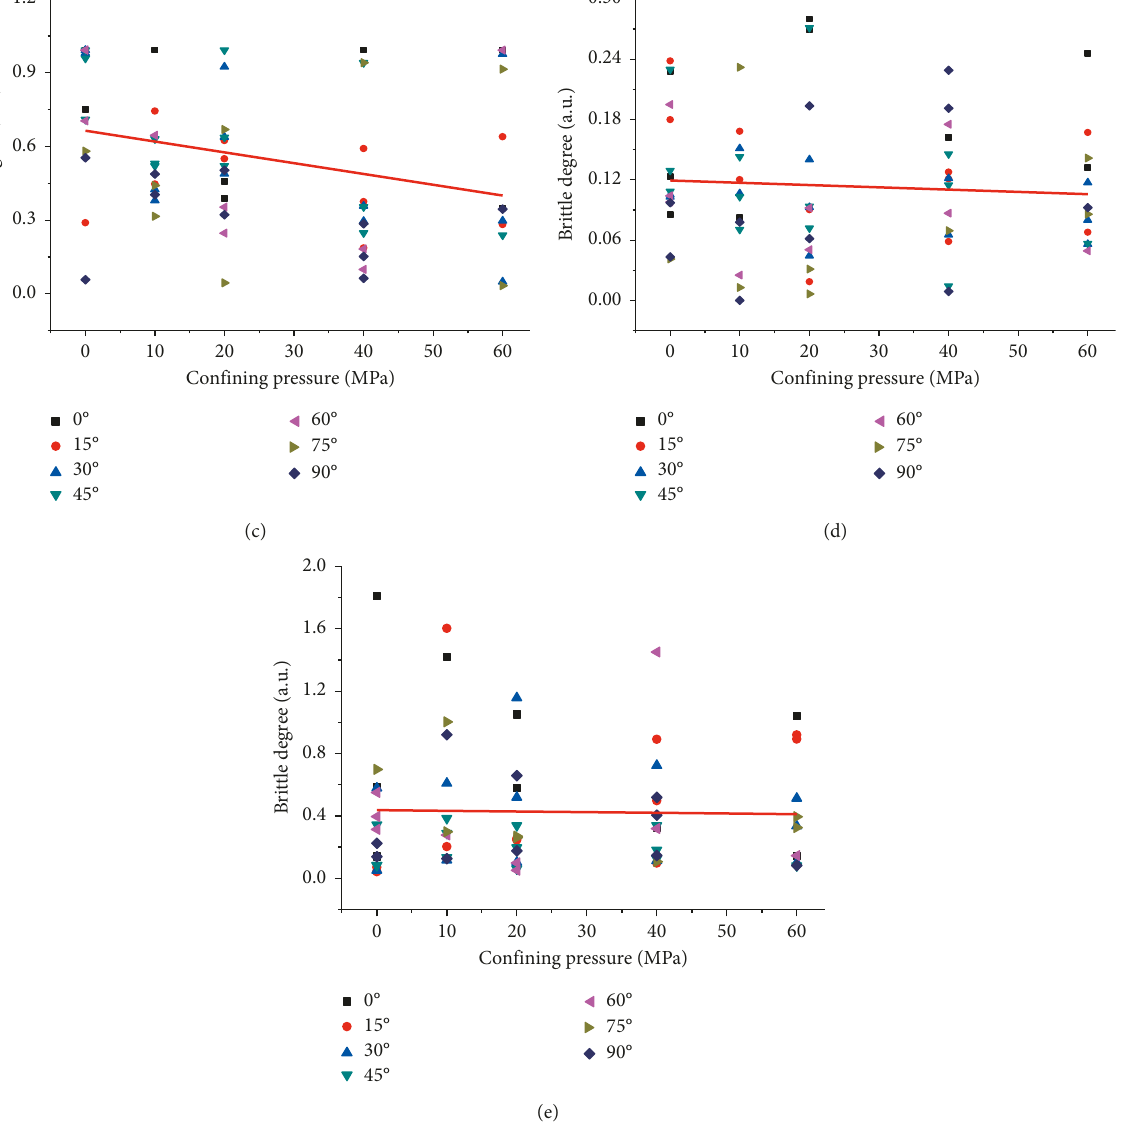
Figure 18: Brittleness based on different indices and confining pressures: (a) index (1), (b) index (2), (c) index (3), (d) index (4), and (e) index